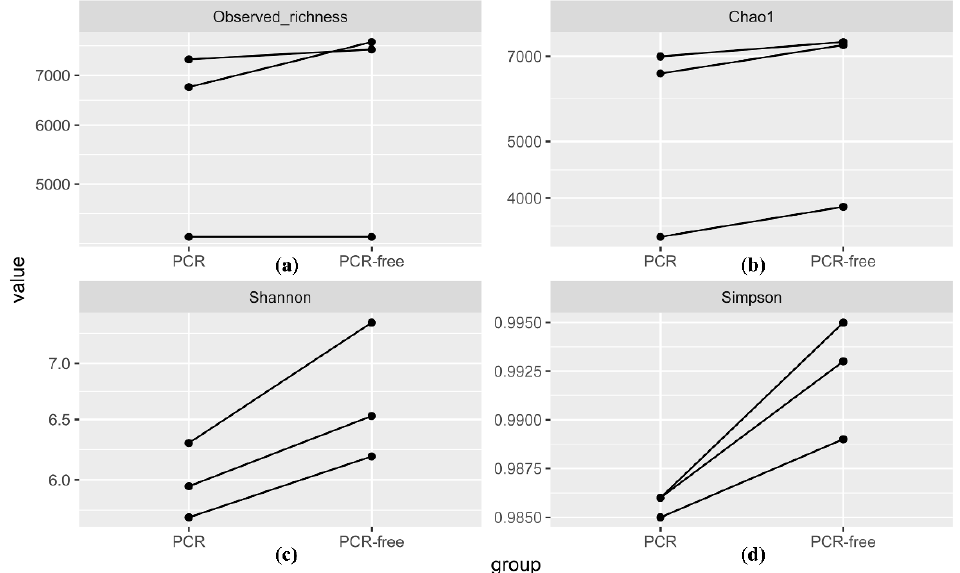
Figure 5. Estimations of the alpha diversity indices. ( a ) The number of vOTUs directly observed from a rarefied count matrix ( p -value = 0.310). ( b ) Estimation of richness using Chao1 index for six virome-derived library datasets ( p -value = 0.045). ( c ) Estimation of Shannon index for the virome datasets ( p -value = 0.063). ( d ) Estimation of Simpson index for the virome datasets ( p -value = 0.044). The p -values were obtained using a paired t-test analysis.